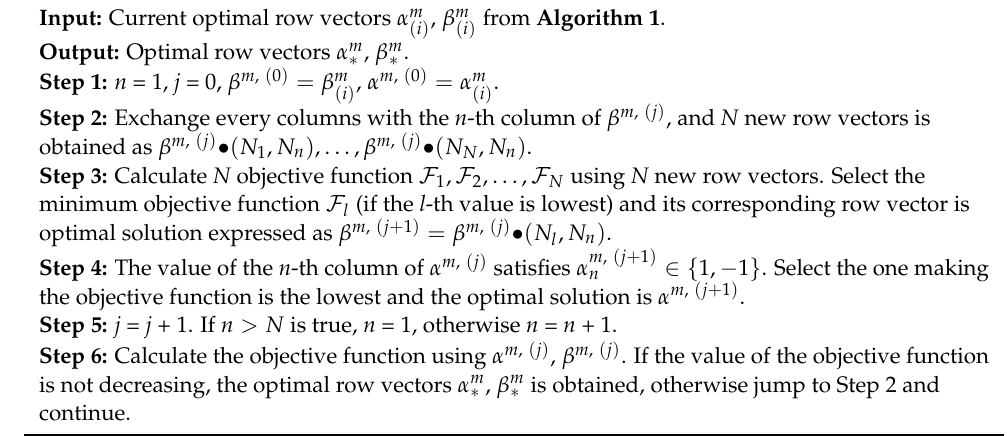
Algorithm 2: The update algorithm for the m -th row of X 2 and X 3